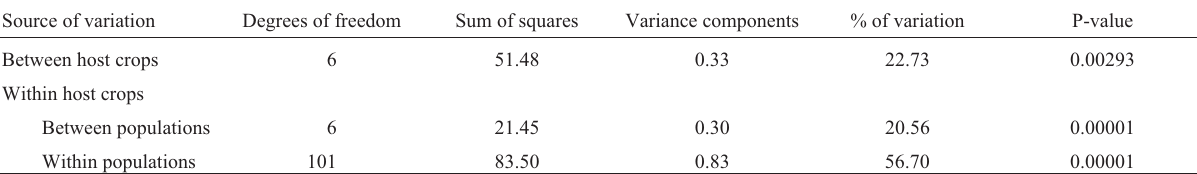
Table III - AMOVA of 109 Bemisia biotype B individuals collected in 12 populations in